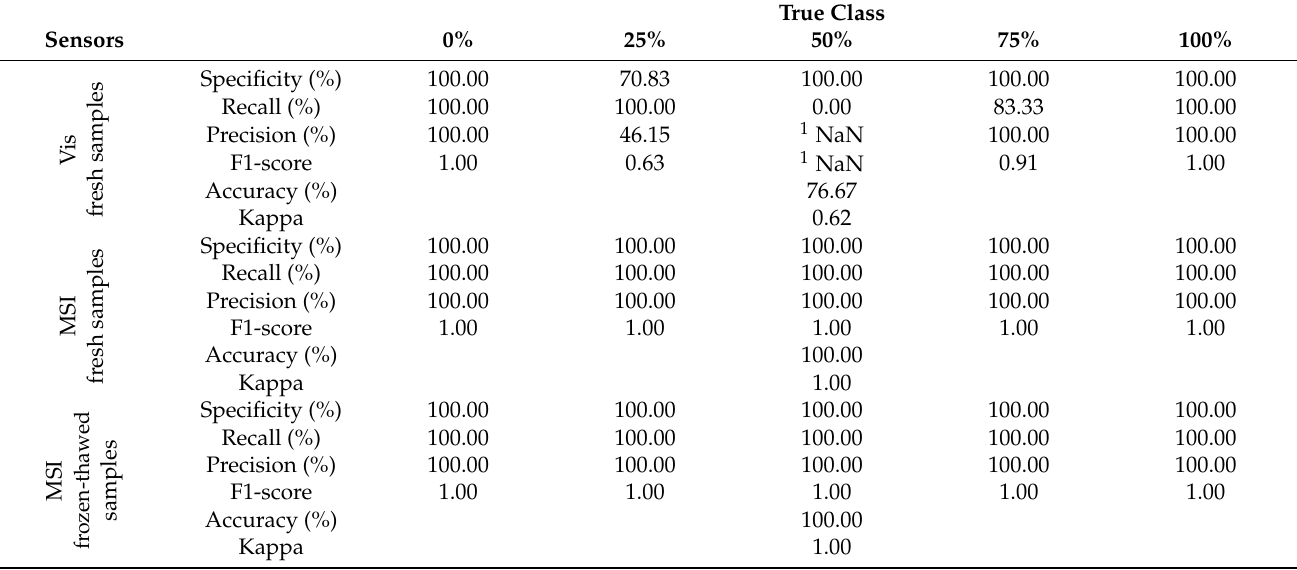
Table 3. Specificity, recall, Precision, F1-score, accuracy and kappa for the classification of SVMs for the external validation ( n = 30) of fresh samples using Vis and MSI data and of frozen-thawed samples using MSI data considering five classes from 0% beef-100% offal (0%) to 100% beef-0% offal